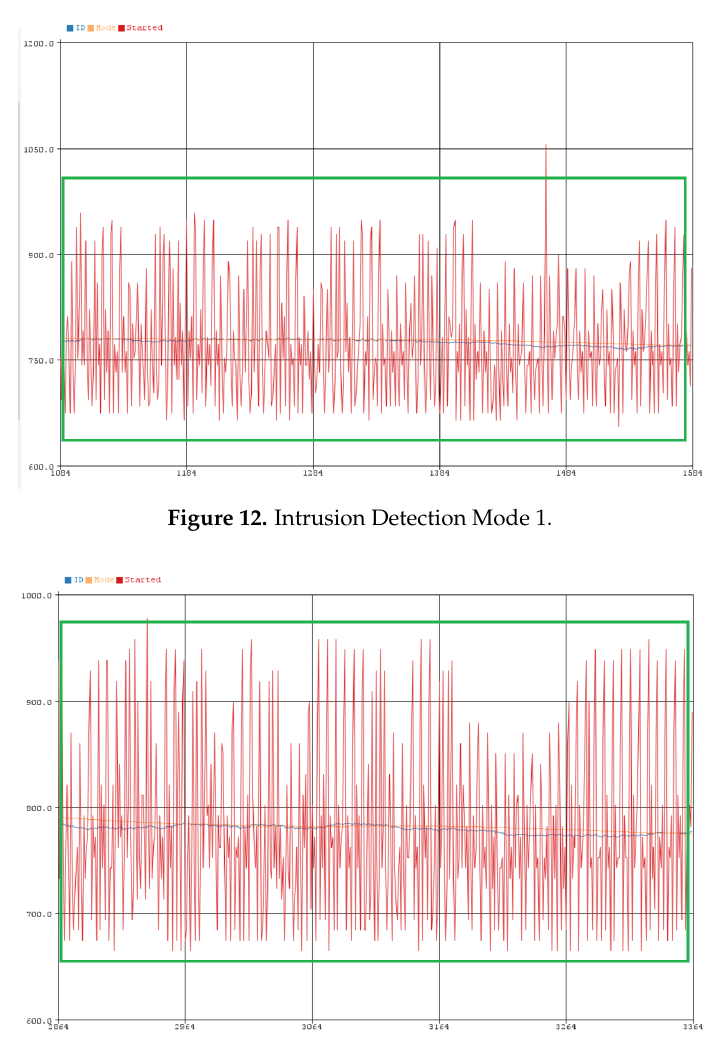
Figure 13. Intrusion Detection Mode